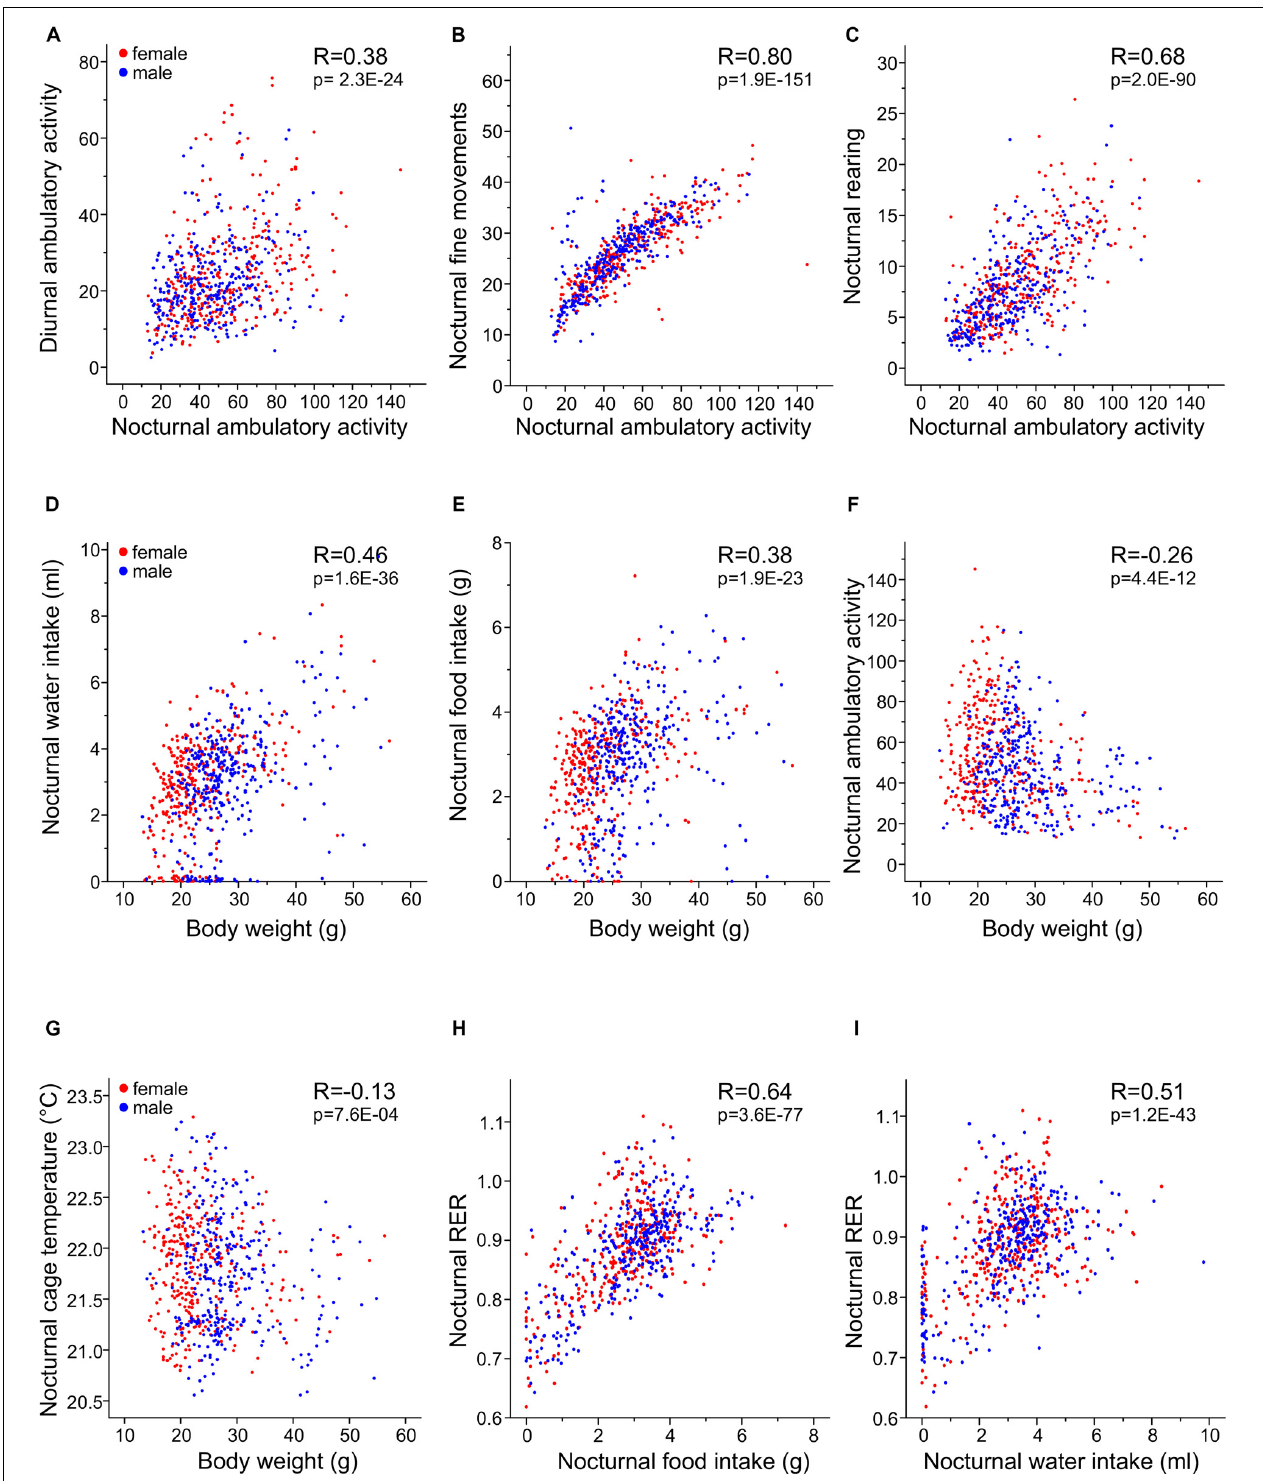
FIGURE 10 | Pearson correlation matrix for selected traits. Illustrations of the relationships between day and nighttime activity parameters (A) and cross-correlation of different nocturnal activity traits, all measured as number of light beam breaks per minute (B,C) . Body mass correlation with nocturnal water (D) and food (E) intake, nocturnal ambulatory activity (F) and cage temperature (G) . Each point represents data from one mouse during one scotophase and its body weight. (H,I) The relationships between nocturnal food intake and water intake with RER. Female mice are shown in red and male mice in blue. The correlations of all other parameters are shown in Table 4 , the p -value was corrected to p <